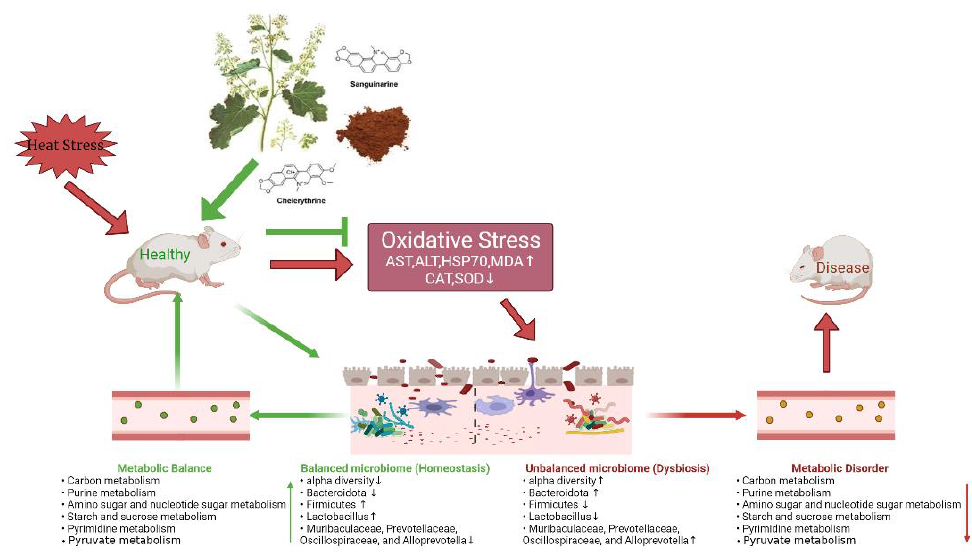
Figure 7. Possible mechanisms of MCE to relieve HS.